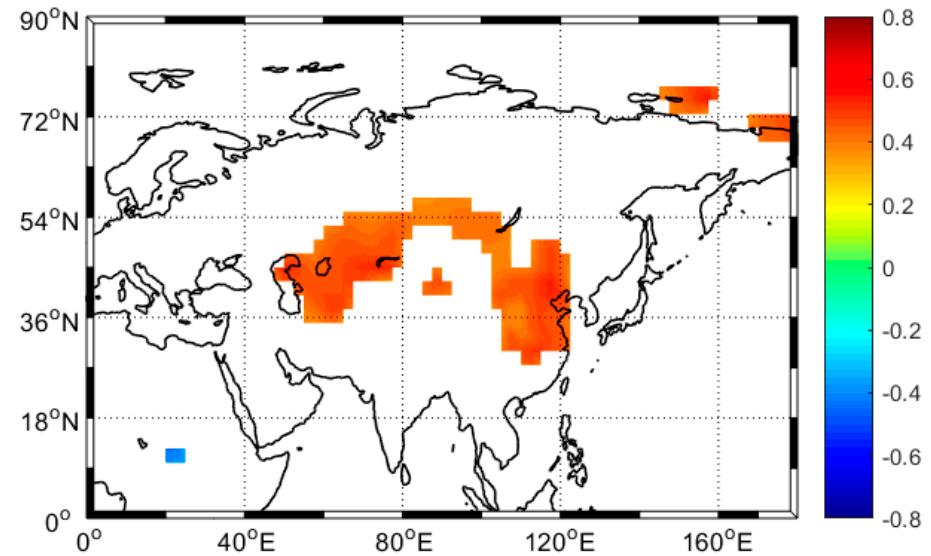
Figure 11. The correlation coefficient between the autumn eastern Siberian Sea ice extent and the winter air temperature at 2 m.